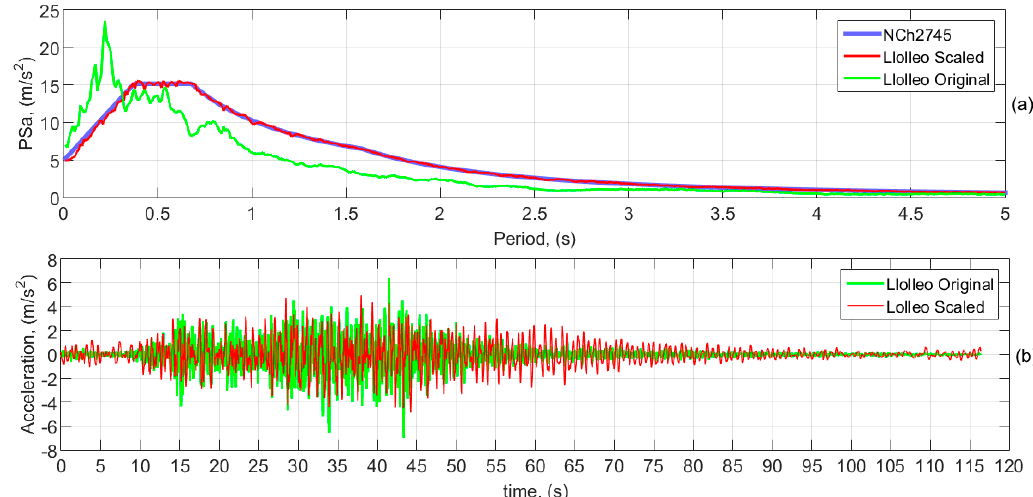
Figure 5. ( a ) Design spectrum of NCh2745, Llolleo’s spectrum scaled to NCh2745 and Llolleo’s original spectrum. ( b ) Llolleo’s earthquake original and scaled to fit NCh2745 spectrum of design.